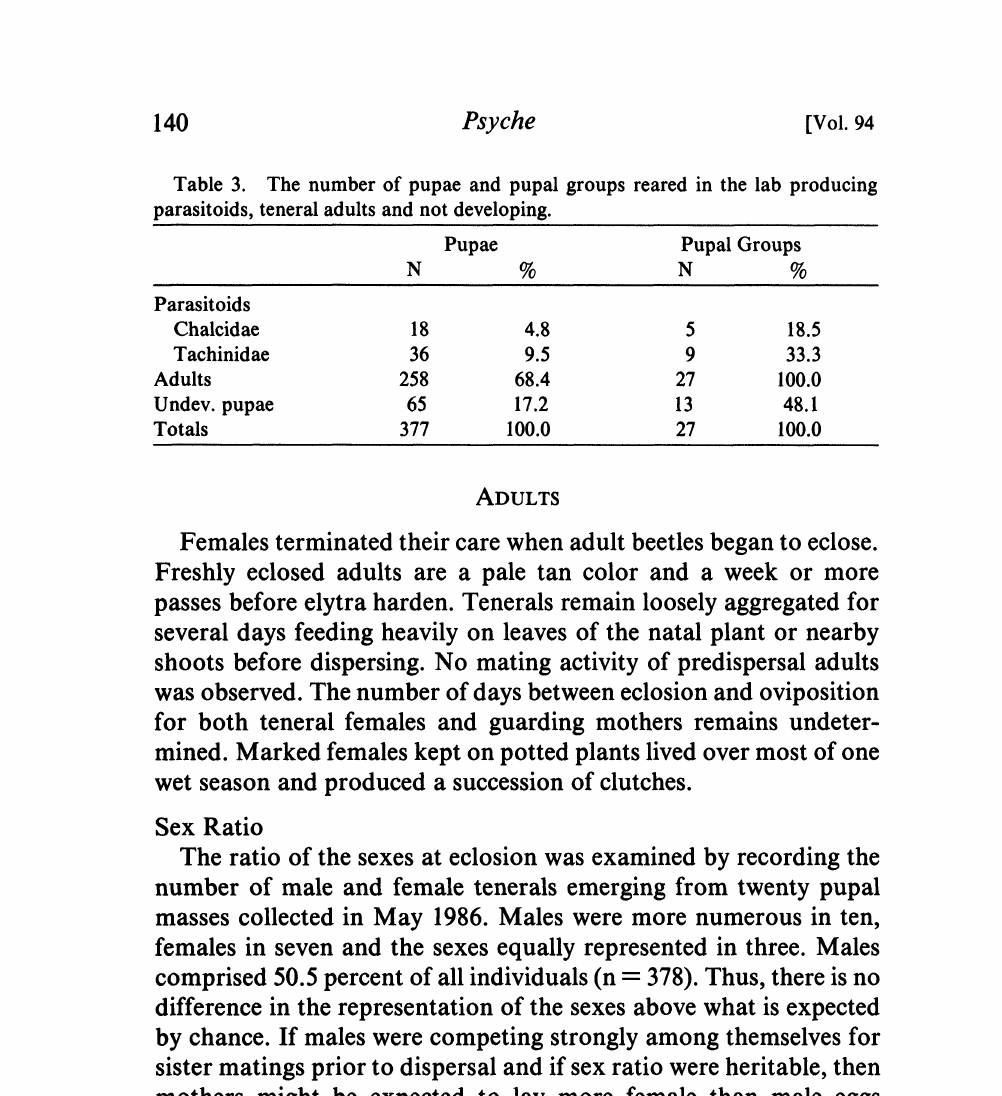
Table 3. The number of pupae and pupal groups reared in the lab producing parasitoids, teneral adults and not